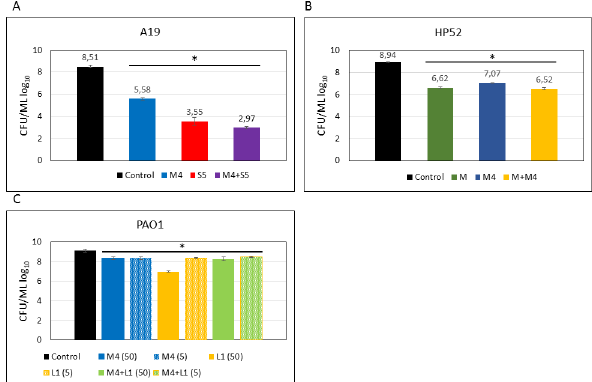
Fig 6. Pyocin antibacterial assaysin liquid culture. P . aeruginosa strains were cultivatedin CAA medium, treated with 5 μ g mL -1 or 50 μ g mL -1 of one or several pyocinsand incubatedwith shakingfor 6.5 hours. The antimicrobial activity of pyocinswas evaluatedby determiningcell numbers of bacterial test culture. Serial dilutionsof 10, 10 − 1 , 10 − 2 , 10 − 3 , 10 − 4 and 10 − 5 were made, plated on LB agar plates, incubatedovernight at 37˚C and the CFU calculated. Data are the mean ± SD of three independentexperiments. * Denotes statistical significance(p (cid:20) 0.001) for comparison of treatment with antimicrobials versus control by a one-way ANOVA test with Bonferroni correction